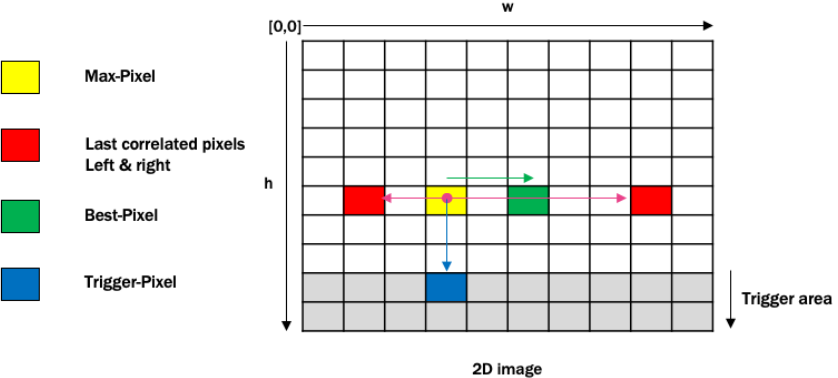
Figure 6. Illustration of correlation and selection of the best pixel.